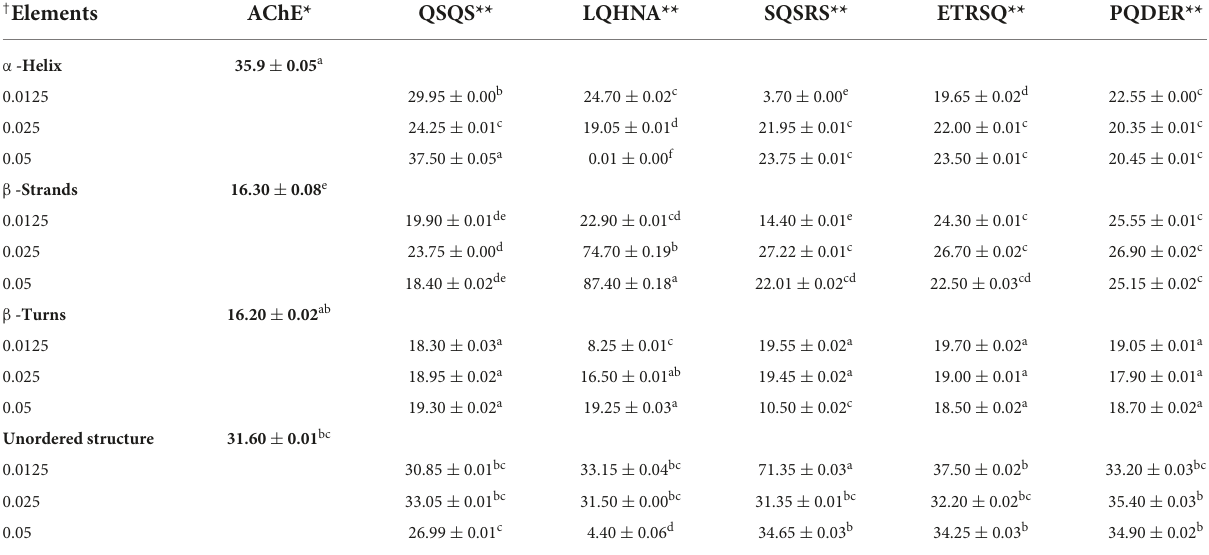
TABLE 3 Estimated secondary structure composition of AChE and AChE-peptide